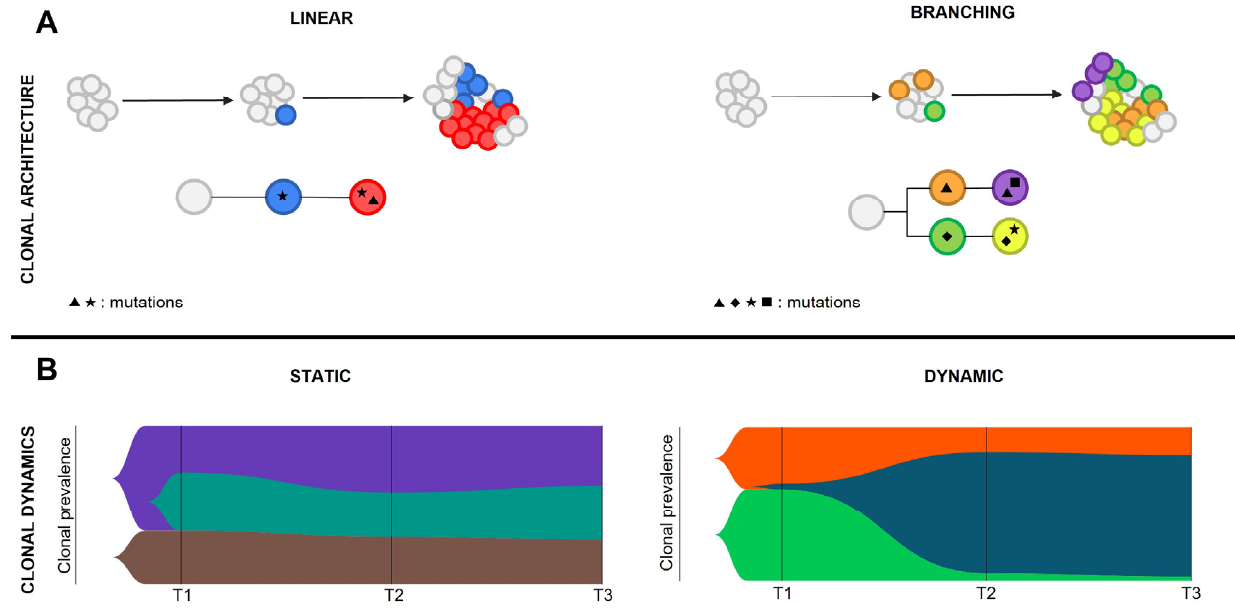
Figure 4. Clonal architecture and dynamics. Figure represents the possible clonal structures observed in MPN patients who evolved to sAML as reconstructed according to single cell genomics studies. Panel ( A ) shows the possible patterns of clonal architecture, while in pale ( B ) are reported fish plots representing the possible clonal dynamics.